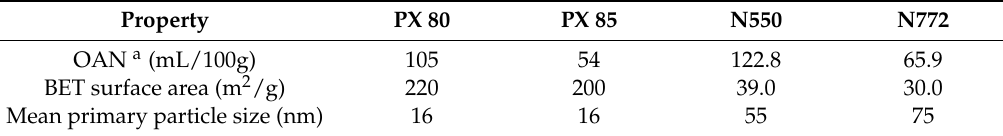
Table 2. Typical properties of the CB